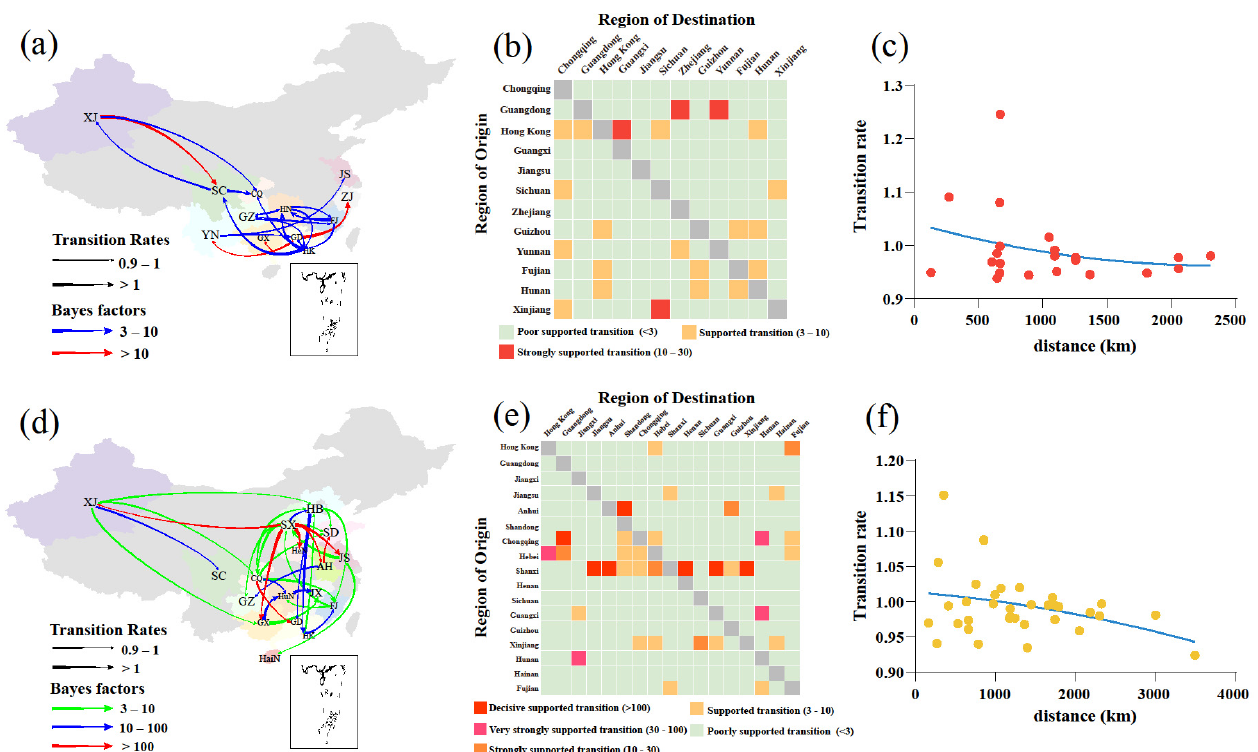
Figure 3. Phylogeographic analysis of clade 2.3.4.4b and 2.3.4.4h H5N6 AIVs was determined by Bayesian phylogeographic inference of HA in China during 2017–May 2020. Spatiotemporal spread of clade 2.3.4.4b H5N6 AIVs ( a ) and clade 2.3.4.4h H5N6 AIVs ( d ) curves show the inter-region virus transitions statistically supported with Bayes factor (BF) > 3; curve widths represent transition rate values; curve colours represent corresponding statistical BF for each transition rate. The heatmaps display the level of BF for each of the transition pathways considered for clade 2.3.4.4b H5N6 analyses ( b ) and 2.3.4.4h H5N6 analyses ( e ), respectively. Inter-region virus transition rates (BF >3) decrease with geodesic distance between different regions for clade 2.3.4.4b H5N6 AIVs ( c ) and clade 2.3.4.4h H5N6 AIVs ( f ), respectively. Abbreviations for the provinces are as follows: HeB: Hebei,